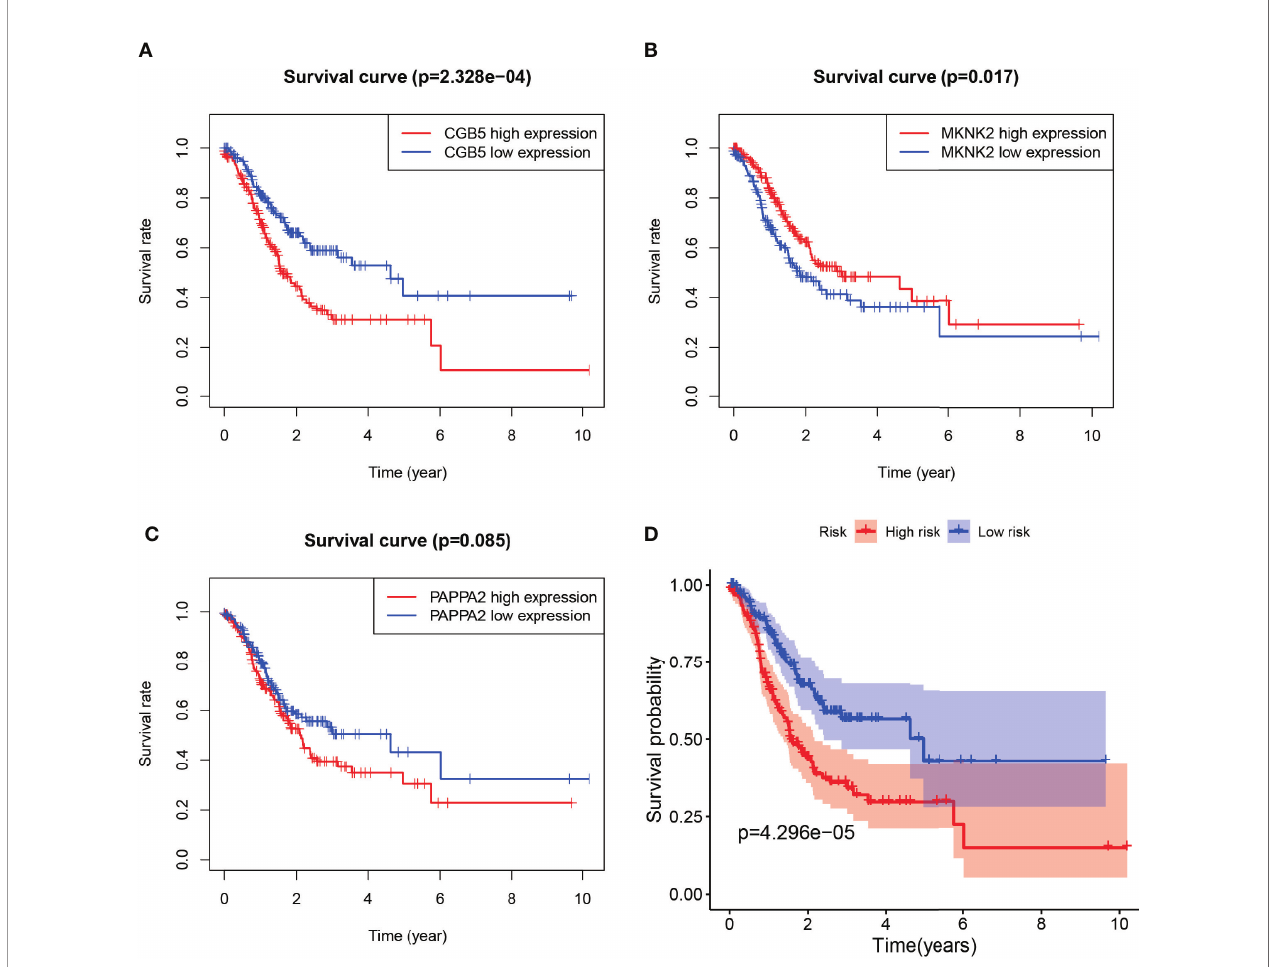
FIGURE 6 | Survival analysis chart. Plots (A – C) represent survival analysis plots constructed based on high and low expression of genes. The (D) -plot represents the survival analysis plot constructed based on the high and low risk values of the constructed